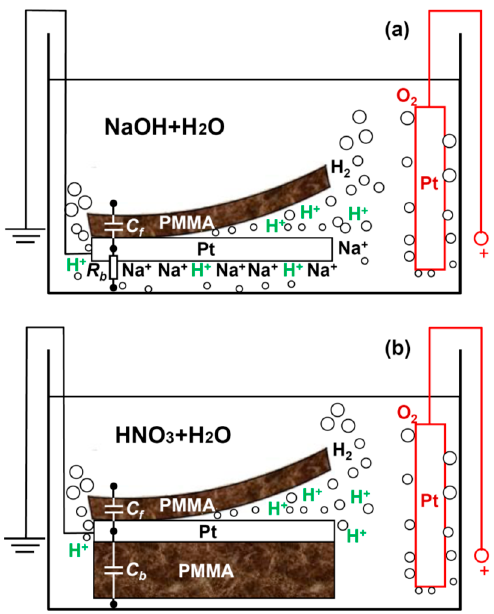
Figure 1. Schematic illustration of the bubbling delamination of a thin PMMA layer from its platinum substrate which is used as the cathode in a water electrolysis cell. To accelerate the process, screening effects against H + reduction at the backside of the Pt are induced either by ( a ) non-reactive cation cloud of Na + from the NaOH electrolyte or ( b ) an undetachable thick insulating PMMA